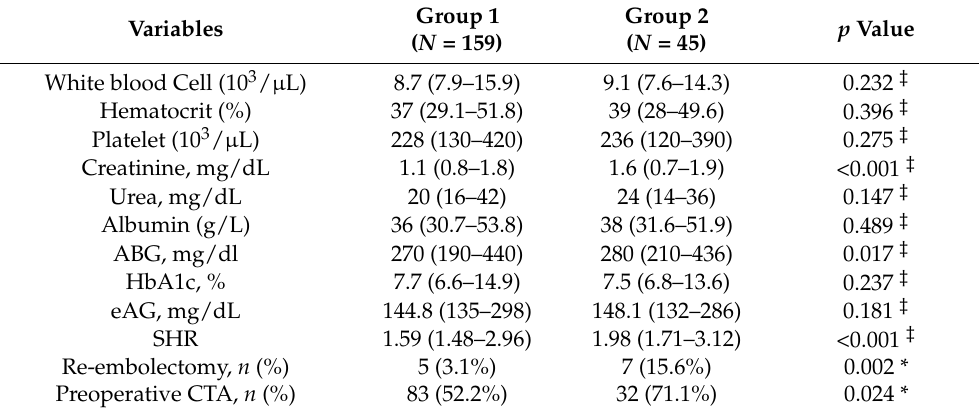
Table 2. Preoperative laboratory and perioperative features of the patients.